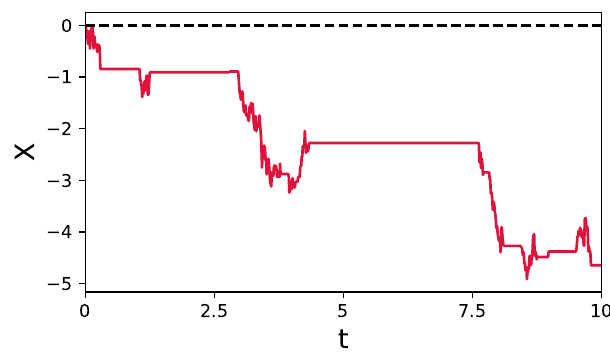
Figure 8. A typical trajectory of particles in the absence of stochastic resetting for D x = 1, D y = 1, and v = −